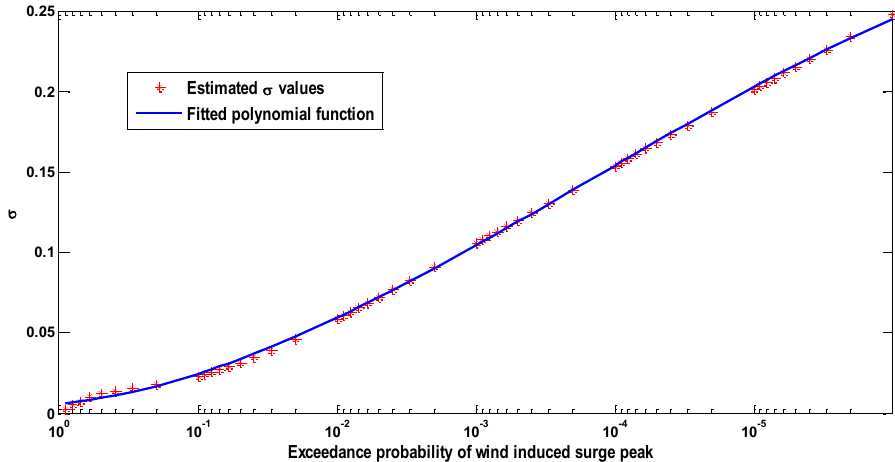
Figure 7. The Log-normal distribution’s parameter σ is modeled as a function of the exceedance probability of the wind induced surge h smax .